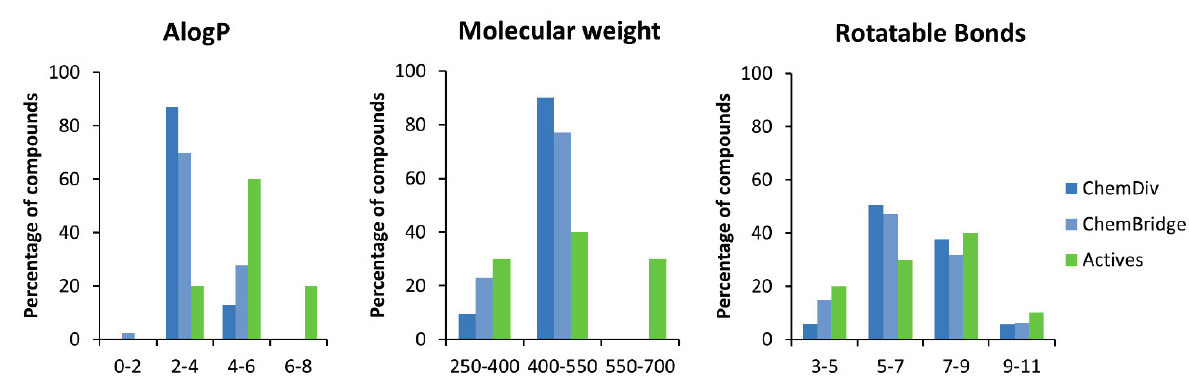
Figure 3. Histograms of selected molecular descriptors for the set of active compounds and the decoy